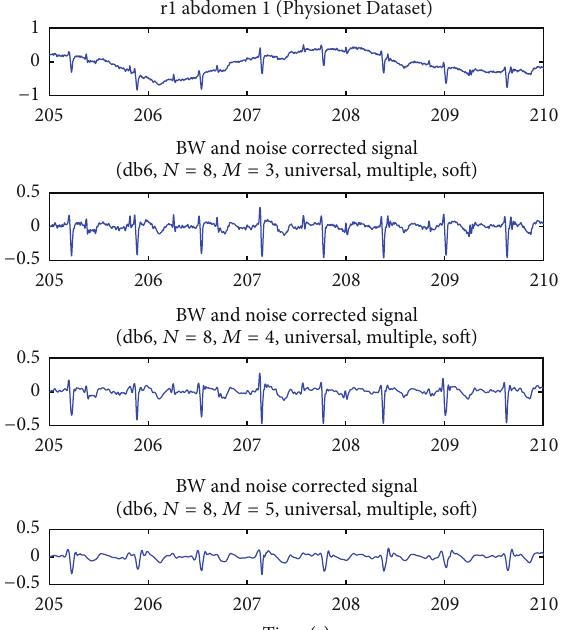
Figure 9: r1 abdomen 1 Abdominal and Direct Fetal Electrocar- diogram Database (Physionet Dataset) signal and BW and noise corrected signals using different levels for denoising.